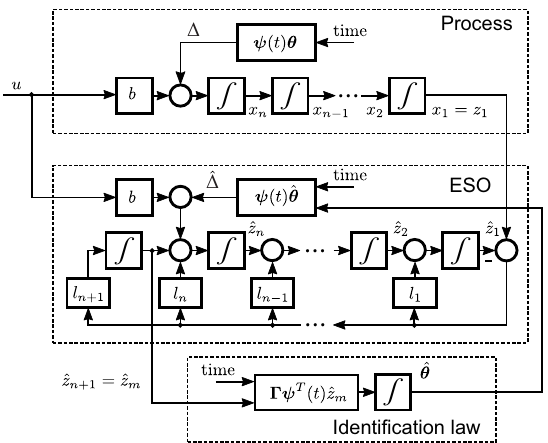
Figure 2. Identification block diagram for the state independent